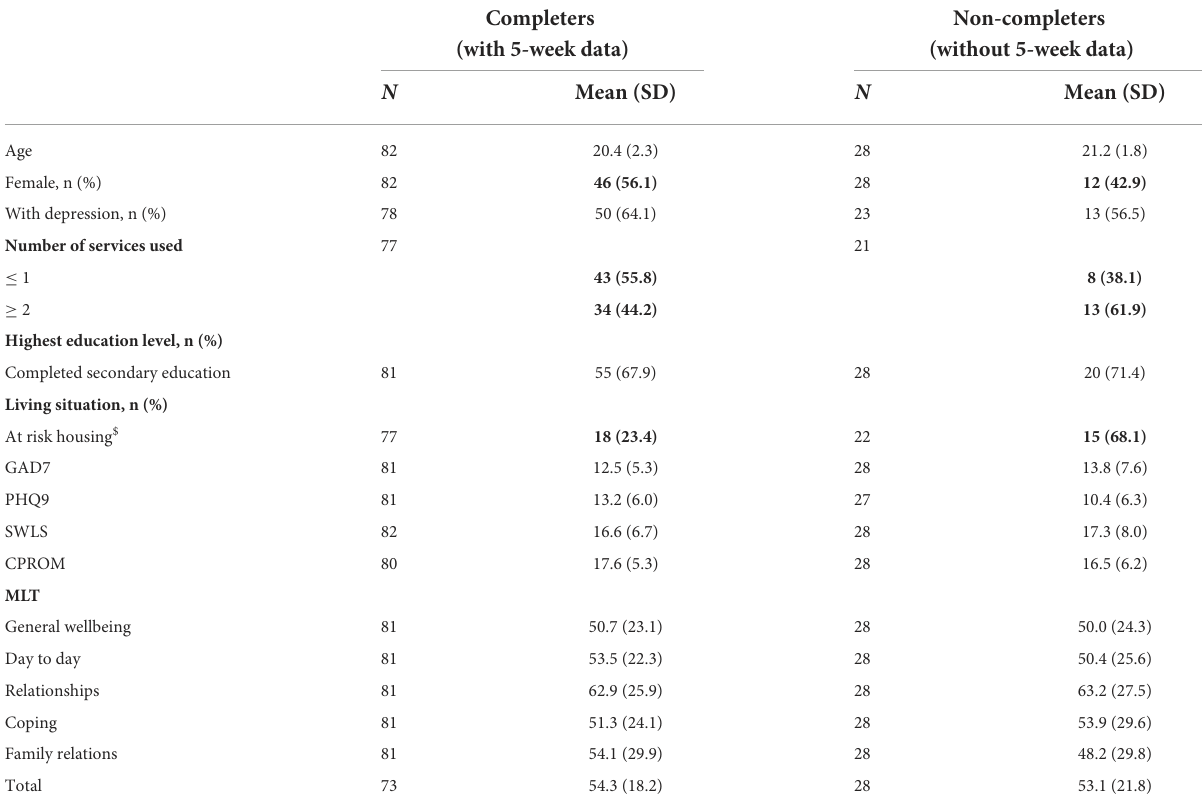
TABLE 5 Comparison of baseline data of completers and non-completers at 5